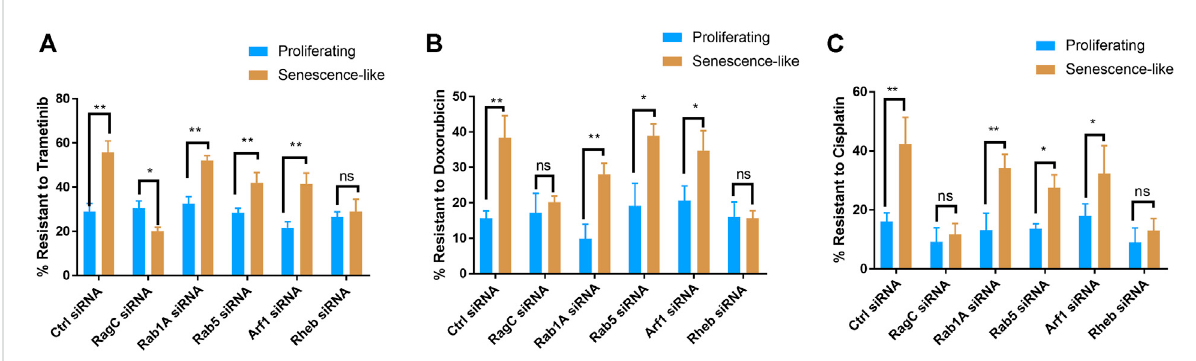
FIGURE 2 Knocking down Rag and Rheb but not Rab1A, Rab5, Arf1 increased drug sensitivity in senescence-like HepG2 cells. (A) RagC and Rheb were required for Trametinib resistance in senescence-like HepG2 cells. Indicated GTPase expression were knocked down by siRNA in proliferating and senescence-like HepG2 cells and drug was added. Viability was determined by CellTiter-glo after 3 days Trametinib (10 nM) treatment. Data were normalized to untreated controls for each experiment. (B) RagC and Rheb were required for Doxorubicin resistance in senescence-like HepG2 cells. HepG2 cells of senescence-like and proliferating counterparts were treated with 100 nM Doxorubicin for 3 days and survival were quanti fi edbyCellTier-glo. (C) RagCand Rheb wererequired forcisplatinresistance insenescence-likeHepG2 cells. HepG2 cellsofsenescence-like and proliferating counterparts were treated with 1 µM Cisplatin for 3 days and survival were quanti fi ed by CellTier-glo. N = 3 experiments were plotted and analyzed by Student ’ s t test p < 0.01(**), p <